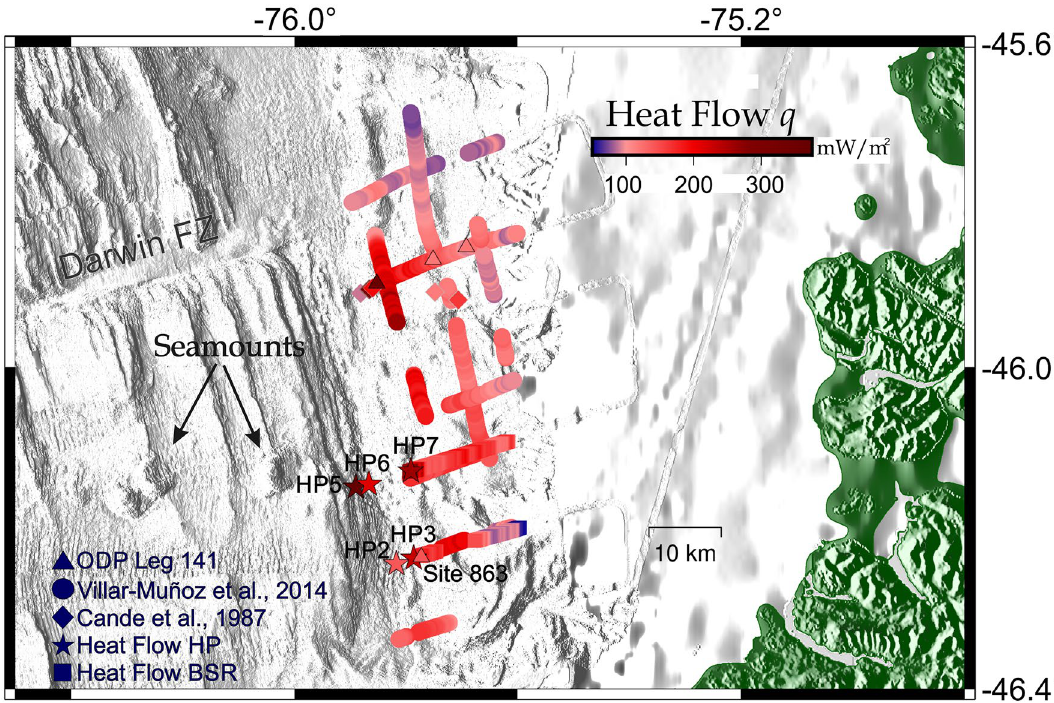
Figure 8. Heat Flow (in mW/m 2 ) compilation around the CTJ after 6 : large-scale colour-coded based on BSR- derived heat flow and heat probes available for the area studied. New heat flow Piston core data are displayed as stars, and new BSR-derived heat flow (seismic profiles MR18-06 Line 01 and 03) data are displayed as squares. Figure generated using GMT—v6.2.0 (https:// www. gener ic- mappi ng- tools.